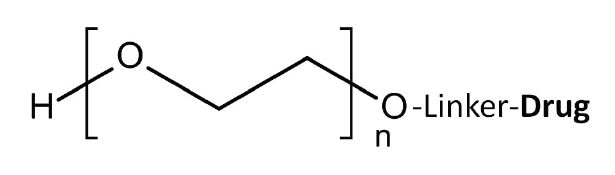
Figure 2. Structure of polyethylene glycol (PEG) and its drug